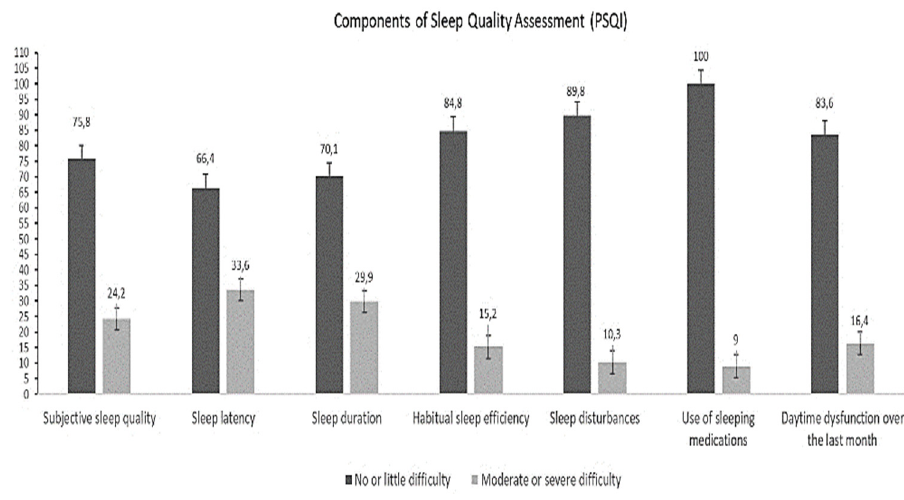
Figure 1. Components of the Pittsburgh Sleep Quality Index in healthcare professionals. Table 1. Prevalence and bivariate analysis of the association between poor sleep quality and daytime sleepiness and socioeconomic, lifestyle, and anthropometric factors, as well as psychosocial work conditions, in health professionals ( n = 244). Poor Sleep Quality Abnormal Drowsiness